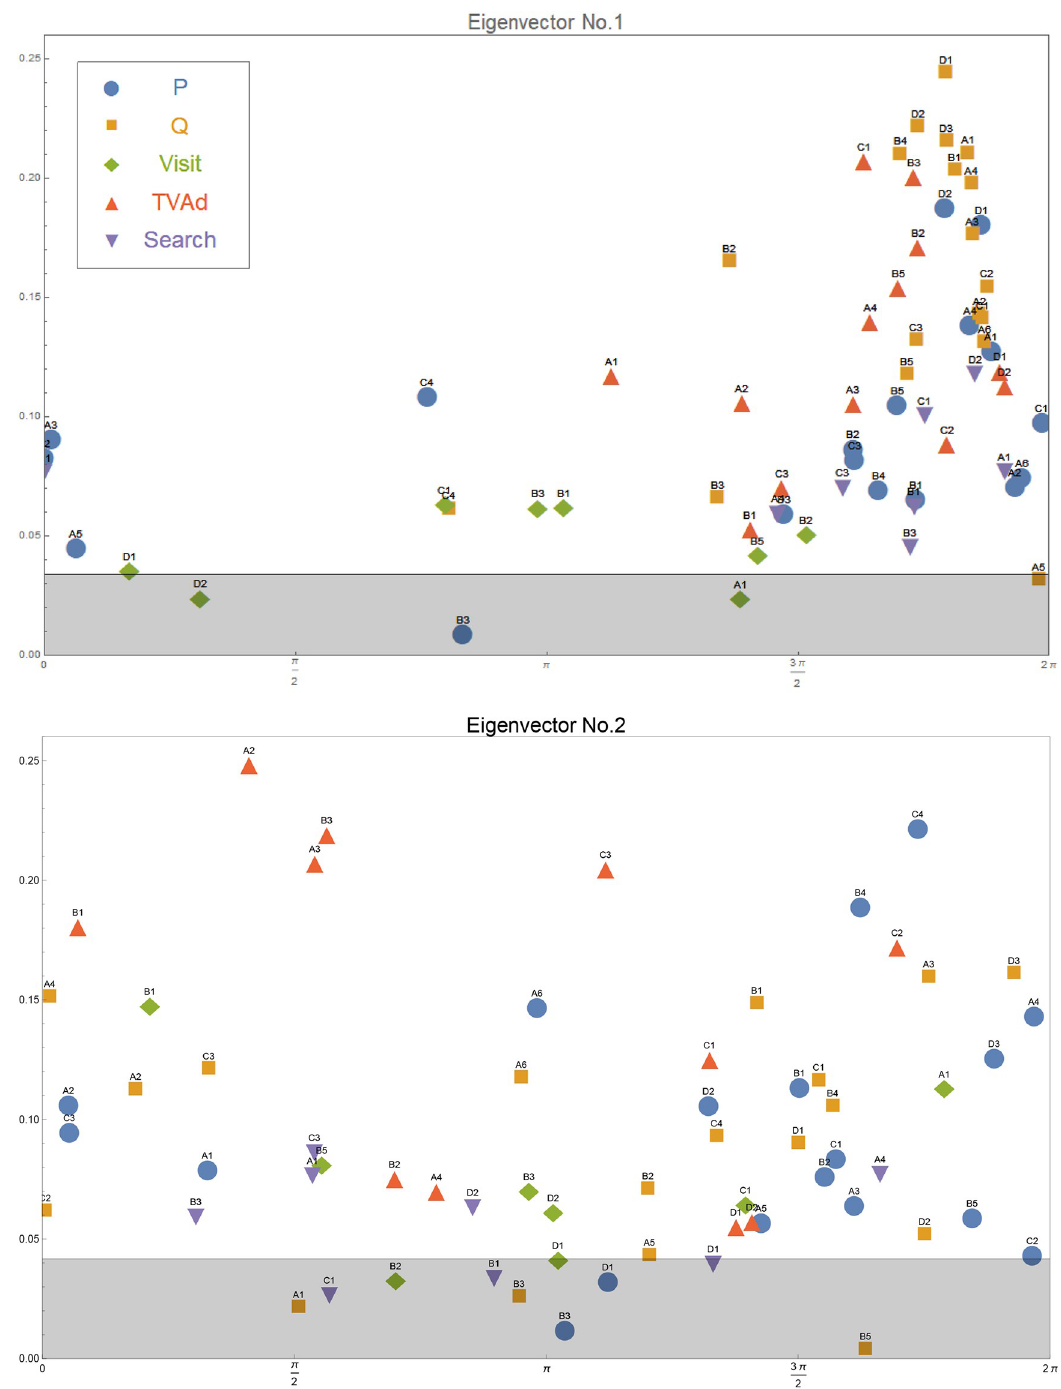
Fig 6. The components of the first (upper) and the second (lower) eigenvectors. Each component is indicated by a marker with the label of product code and style. Horizontal position is each component’s phase, and vertical position is its absolute magnitude. See more in the main